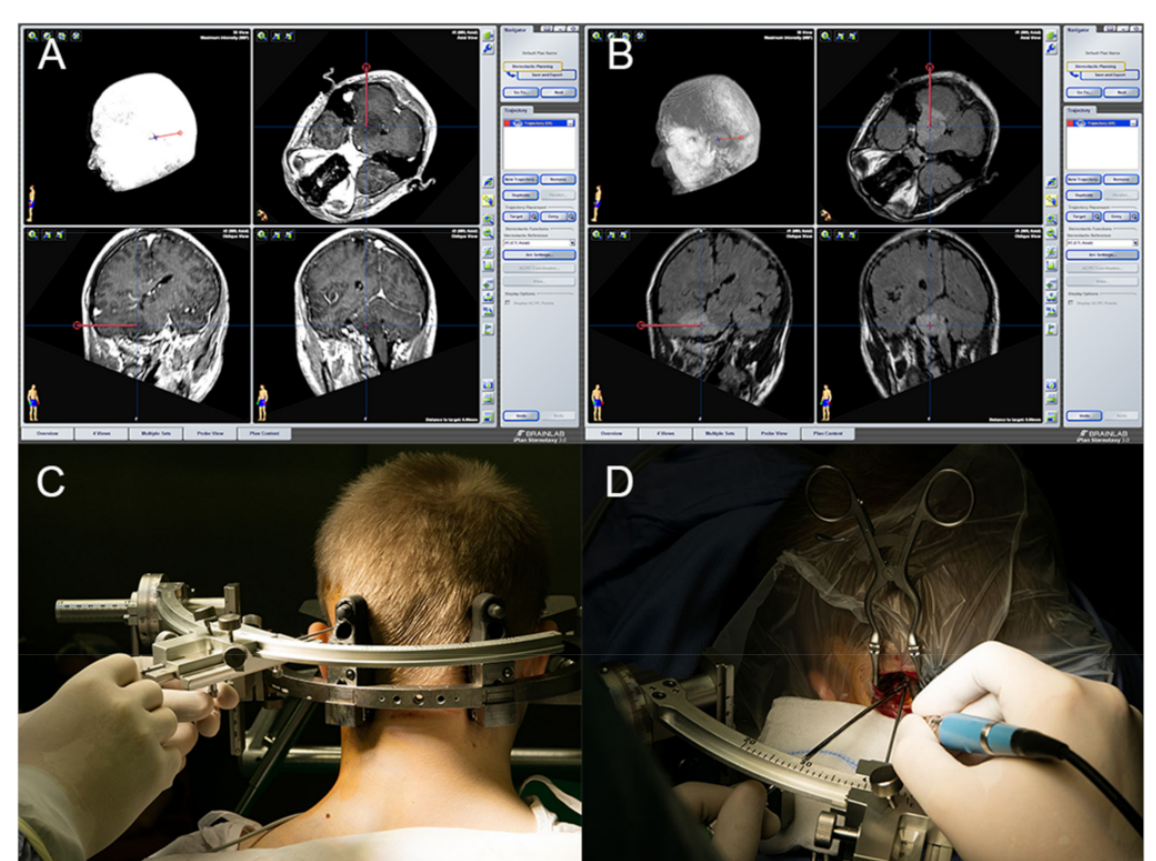
Figure 2. ( A ) T1-weighted image of a tumor located in the pons, cerebellar peduncle, and cerebellar hemisphere. ( B ) Fluid attenuated inversion recovery magnetic resonance imaging (FLAIR MRI) of a tumor located in the pons, cerebellar peduncle, and cerebellar hemisphere. ( C ) Patient with a stereotactic frame. ( D ) Suboccipital burr holes made using a high-speed